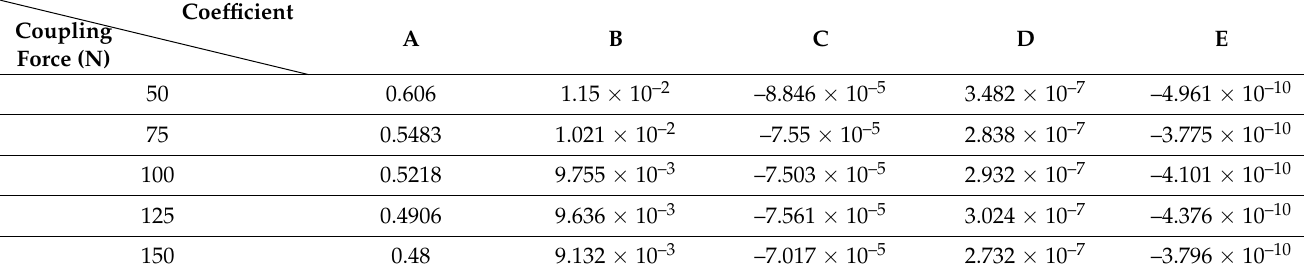
Table 1. Numerical values of the coefficients for calculating the coupling factor according to ISO/TS 15230-2